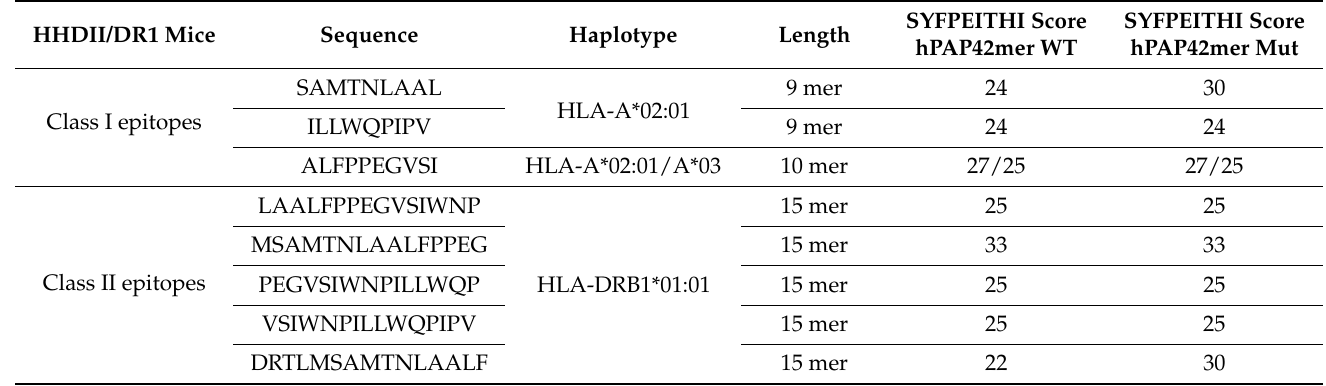
Table 2. List of HLA-A*02:01 class-I and HLA-DRB1*01:01 class-II peptides derived from the hPAP42mer sequence.